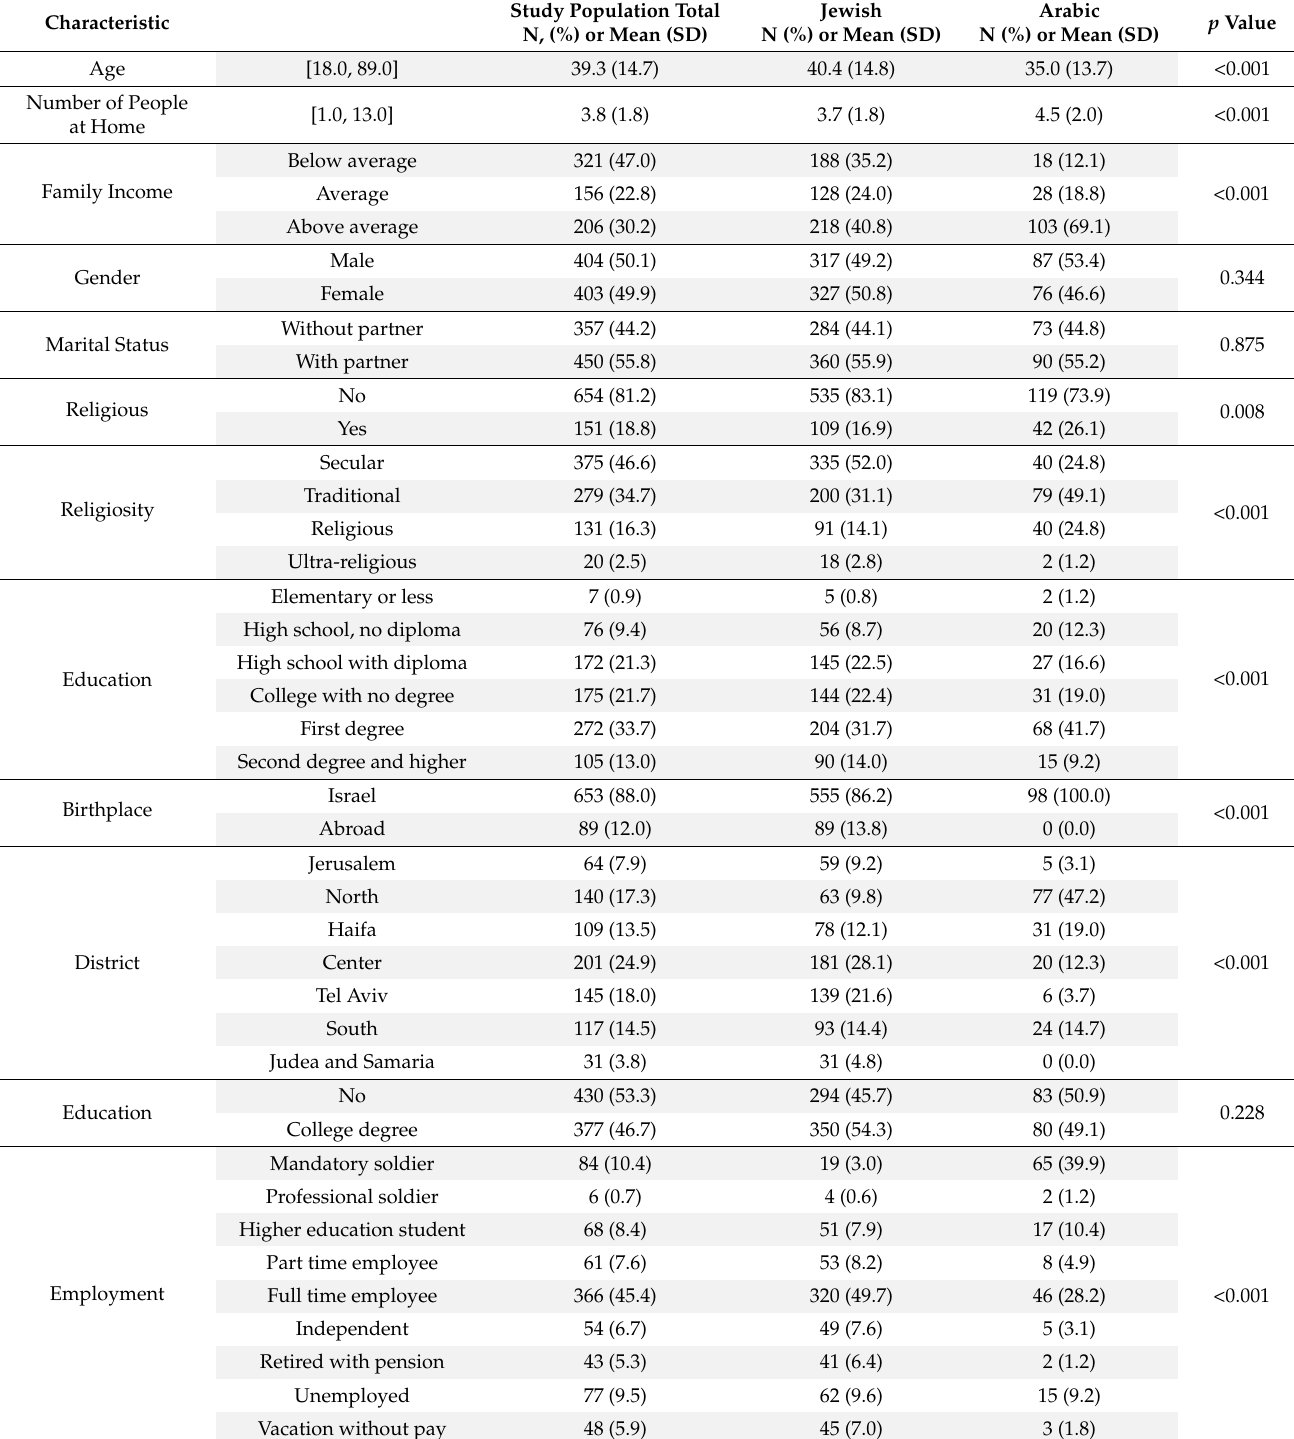
Table 1. Demographic statistics by